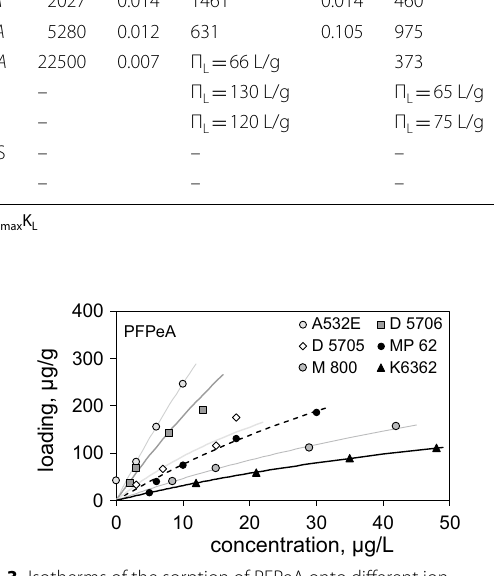
Fig. 3 Isotherms of the sorption of PFPeA onto different ion exchangers (matrix: tap water)